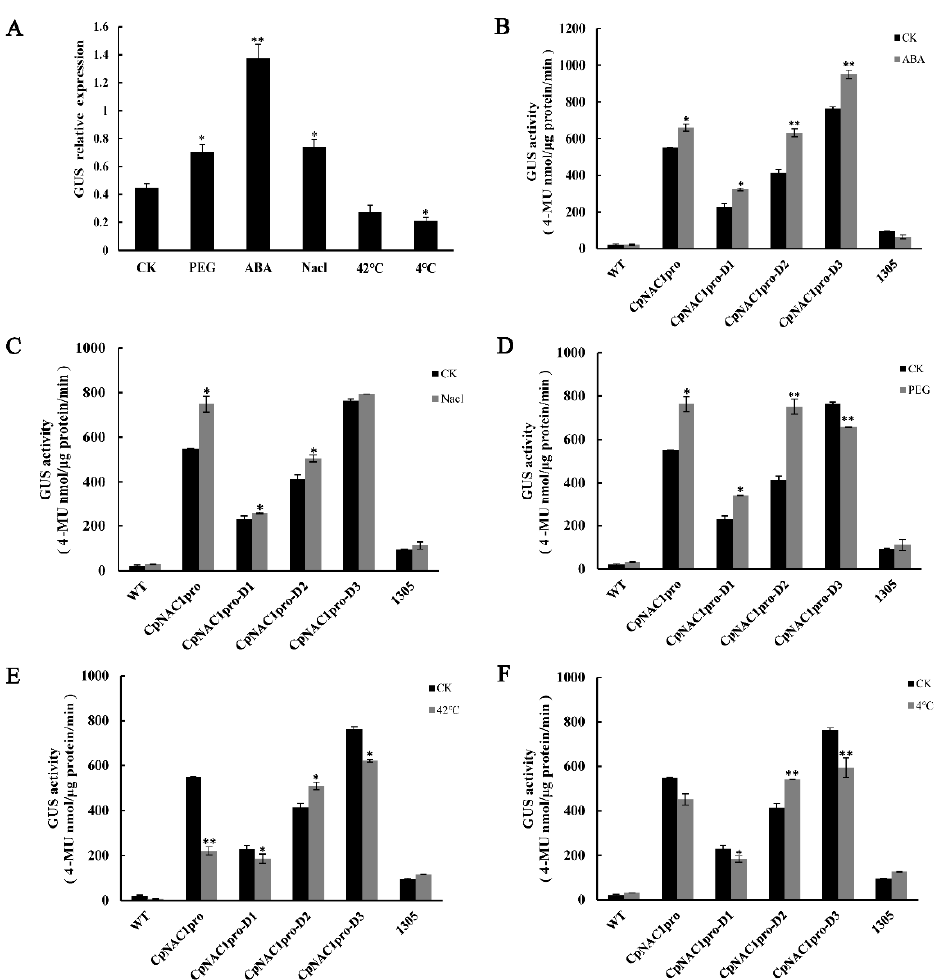
Figure 7. CpNAC1 promoter activity in response to abiotic stress and hormone treatments. ( A ) Expression patterns of the GUS gene in CpNAC1pro:GUS transgenic Arabidopsis plants. ( B – F ) Transgenic Arabidopsis GUS enzyme activity after different treatments. Ten-day-old T3 homozygous transgenic Arabidopsis seedlings were treated with 50 µM ABA, 150 mM NaCl, 10% PEG for 24 h; heat stress at 42 °C for 6 h; or cold stress at 4 °C for 24 h. Plants grown under normal conditions were used as controls. Data represent means of three biological repeats ± standard deviations (SDs). Asterisks denote statistically significant differences compared to controls, * p < 0.05, ** p < 0.01.